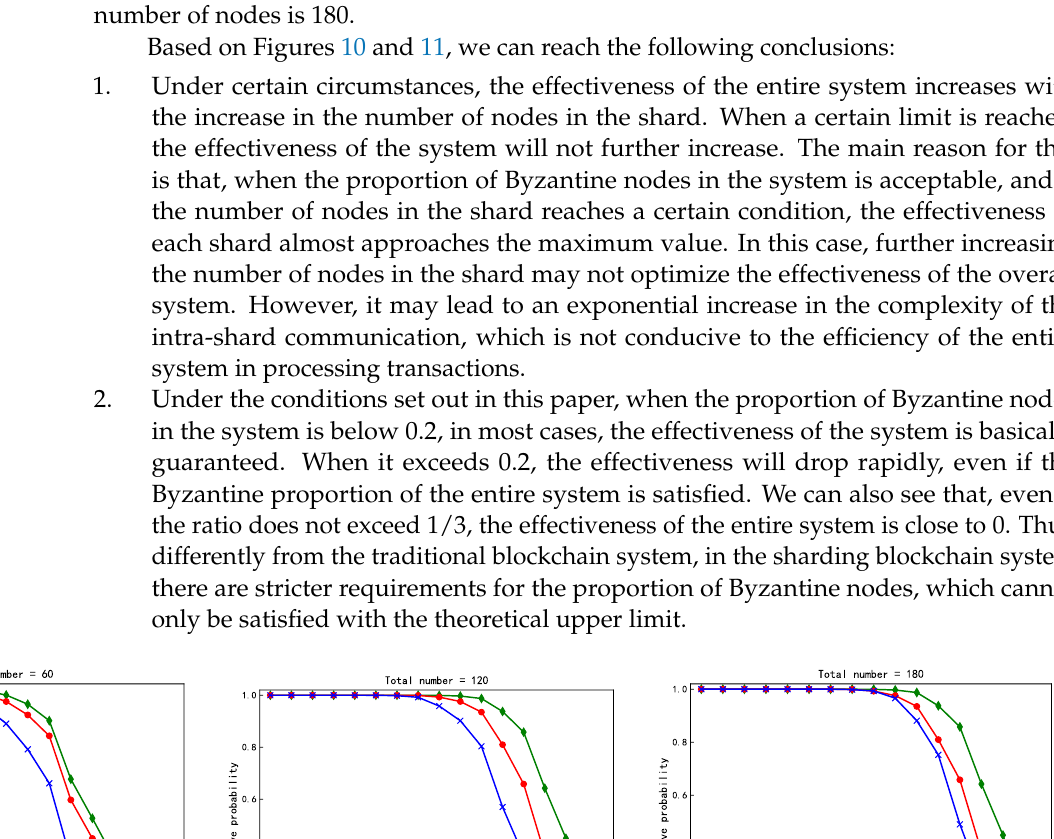
Experiment 2: Analysis of the overall effectiveness of the system based on the scale of shards. Experiment 3: Overall effectiveness analysis of the total number of nodes in the system These three figures respectively describe the probability that the entire system is ef- fective when the total number of nodes is the same and the number of shards is differ- ent.Among which (a) The total number of nodes is 60; (b) The total number of nodes is 120; (c) The total number of nodes is 180.